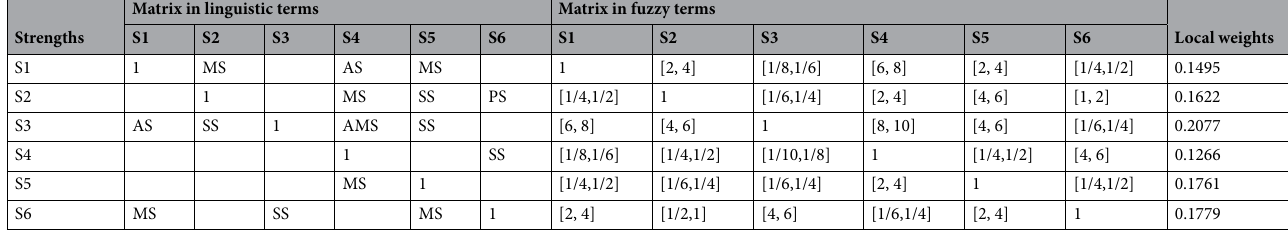
Table 4. Evaluation criteria of the Strengths. (C.R. = 0.098).